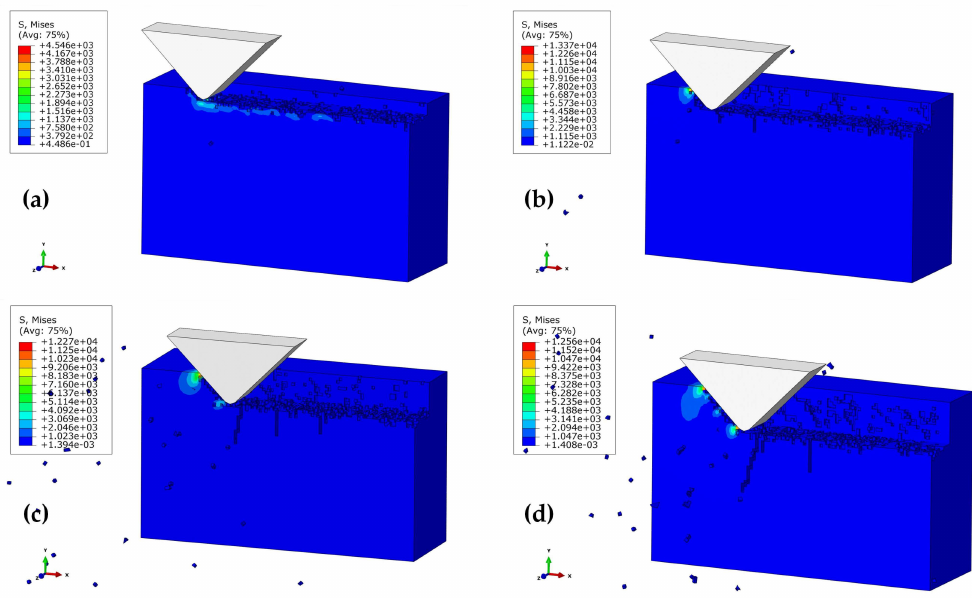
Figure 7. Effect of polishing depth on the depth of subsurface damage (SSD) at the polishing speed of 1361 mm/s, and the height of the abrasive grain of h = 7 µ m: ( a ) a p = 1 µ m; ( b ) a p = 2 µ m; ( c ) a p = 3 µ m; ( d ) a p = 4 µ